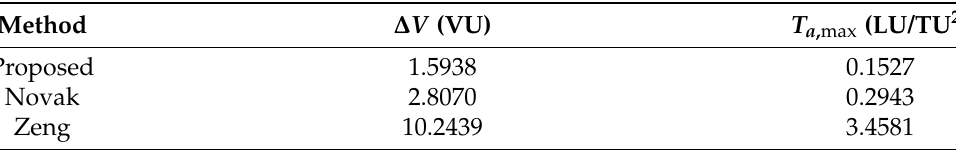
Figure 5. Thrust acceleration T a of three methods when r 1 < r 2 . Table 2. Orbit rendezvous results when r 1 < r 2